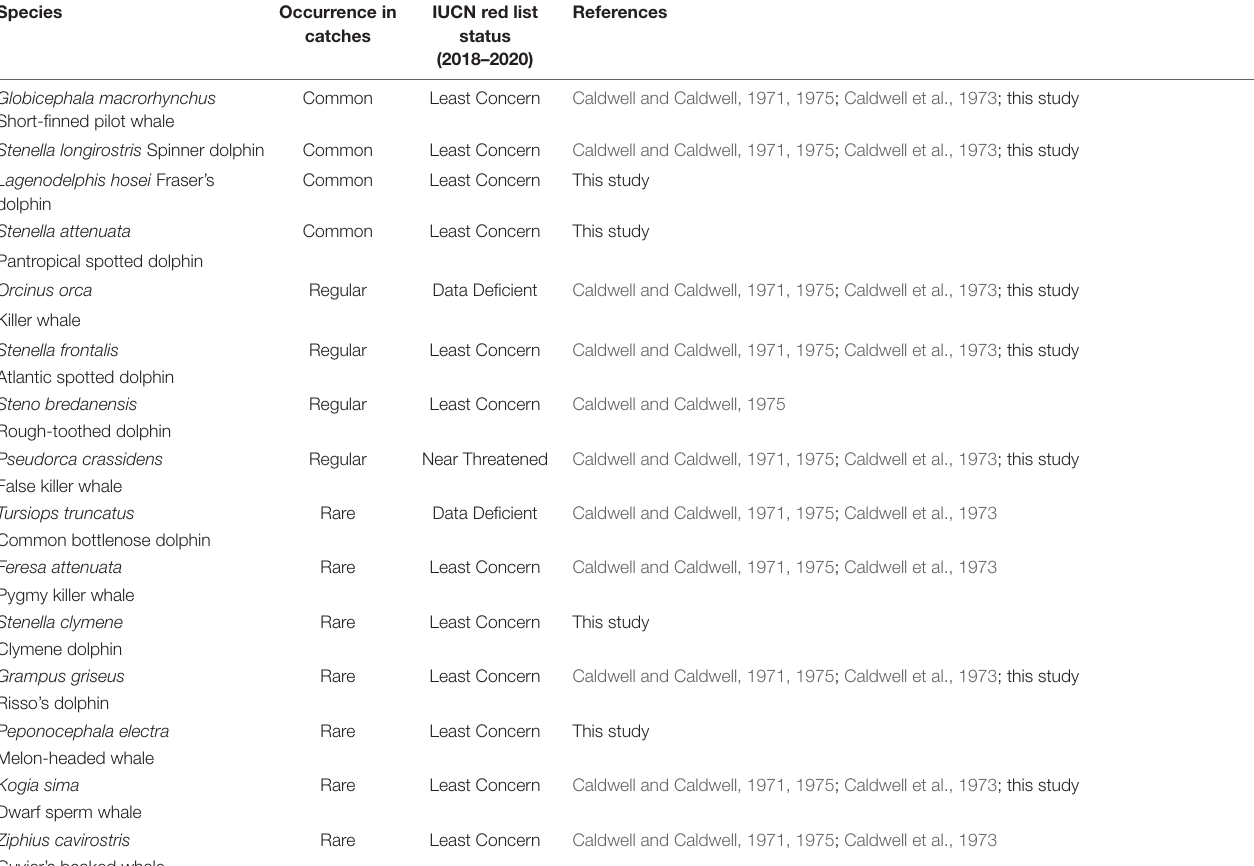
TABLE 1 | Small cetacean species diversity, relative occurrence (common, regular, rare) in captures in Saint Vincent and the Grenadines (1949–2017), and their IUCN Red List Conservation